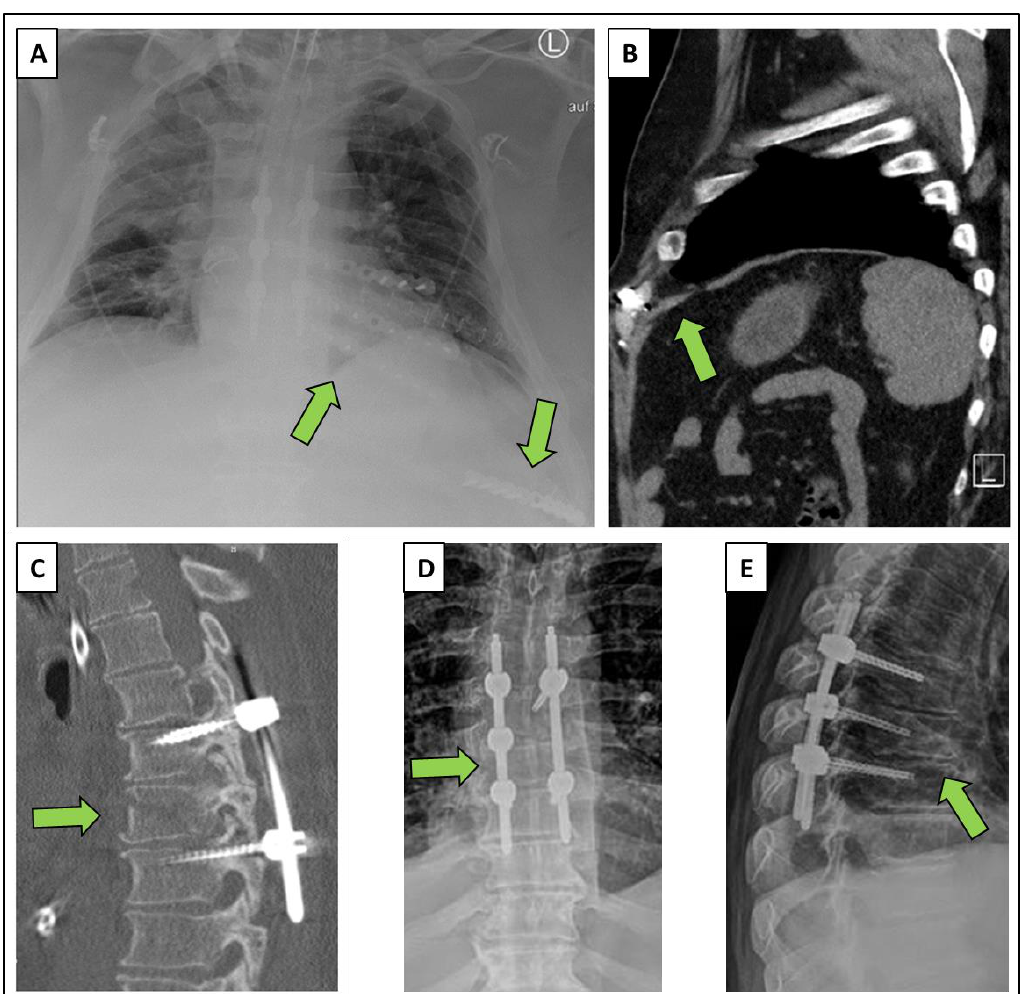
Figure 2. Postoperative X-ray and CT scan: ( A ) thoracic anterior-posterior view, ( B , C ) sagittal CT slices, ( D ) anterior-posterior view of the spine, ( E ) lateral view of the spine. The respective injuries and their treatment are marked with arrows. A multistage procedure with a focus on damage control